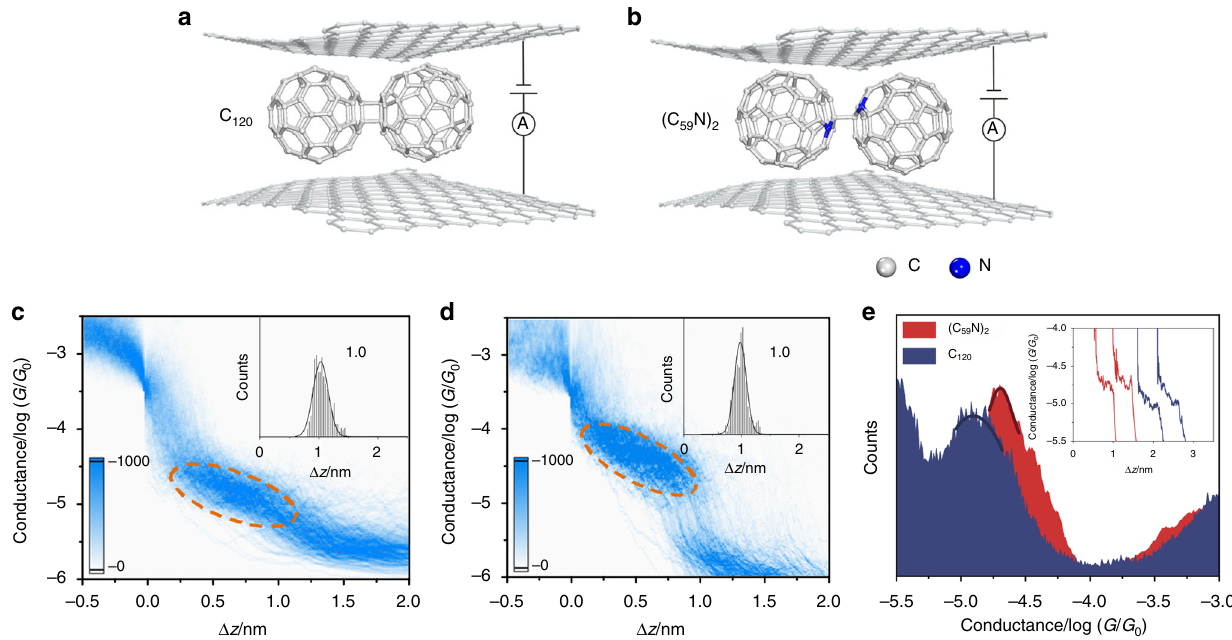
Fig. 3 Heteroatoms doping in graphene/single-fullerene/graphene junctions. a , b Schematic of graphene/single-C 120 ( a ) and (C 59 N) 2 ( b )/graphene junctions. c , d Corresponding two-dimensional conductance histogram obtained from ~1000 traces of C 120 ( c ) and (C 59 N) 2 ( d ). The top right inset is the relative displacement distribution (The conductance range to determine the displacement of C 120 and (C 59 N) 2 are from 3.2 × 10 − 4 to 4.0 × 10 − 6 G 0 , 1.0 × 10 – 5 G 0 , respectively.). e Ono-dimensional conductance histogram of the graphene/single-fullerene/graphene junctions composed of C 120 and (C 59 N) 2 . The top right inset is the individual conductance – displacement